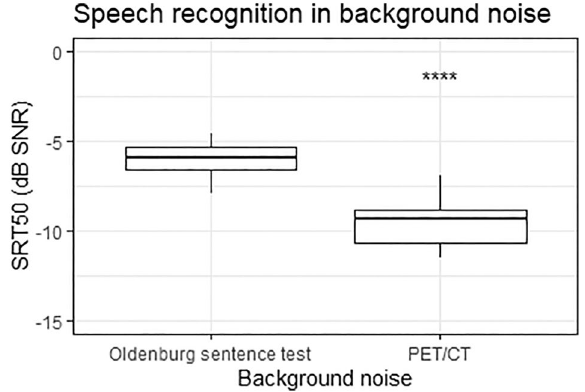
Figure 4. Box-and-whisker plots of the 50% speech reception threshold (SRT50) obtained for sentences in background noise of the Oldenburg sentence test at 76.9 dB SPL or PET noise (Philips Vereos PET/CT) at 76.9 dB SPL in subjects with normal